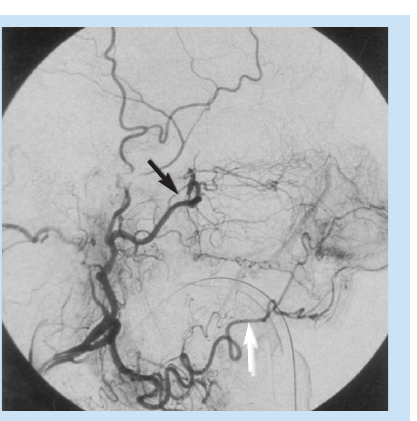
Fig 2a. Selective external carotid digital subtrac- tion arteriogram showing the arterial supply to the nasal cavity via terminal branches of the internal maxillary artery (black arrow) and facial artery (white arrow).